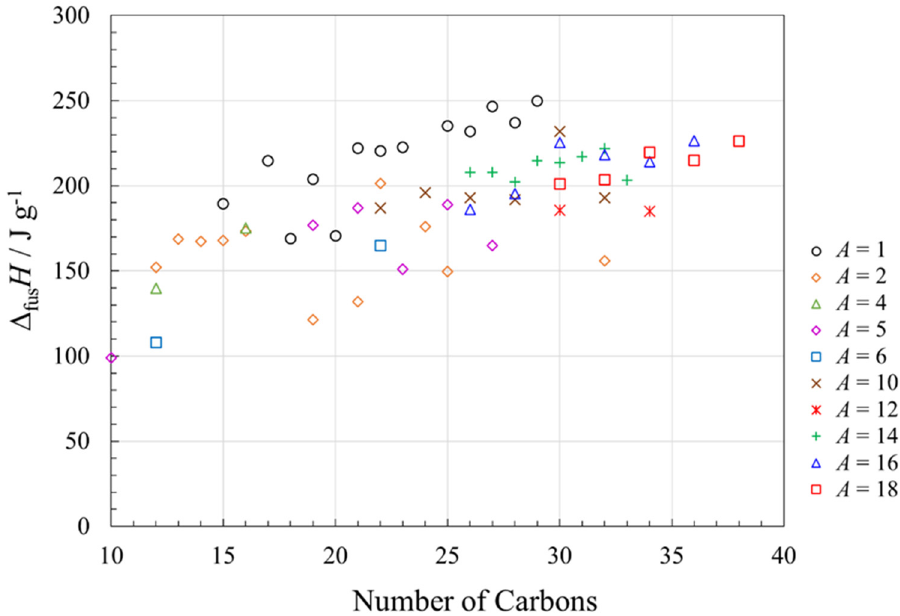
Figure 8. Gravimetric enthalpy changes ( ∆ H in J g − 1 ) associated with fusion (melting) of linear saturated esters of general formula CH 3 (CH 2 ) m − 1 -O-C(O)-(CH 2 ) n - m − 2 CH 3 where A is the length of the alkyl chain ( A = m ), as a function of the total number of carbons in the molecular structure. See Supplementary Information for data and data sources.